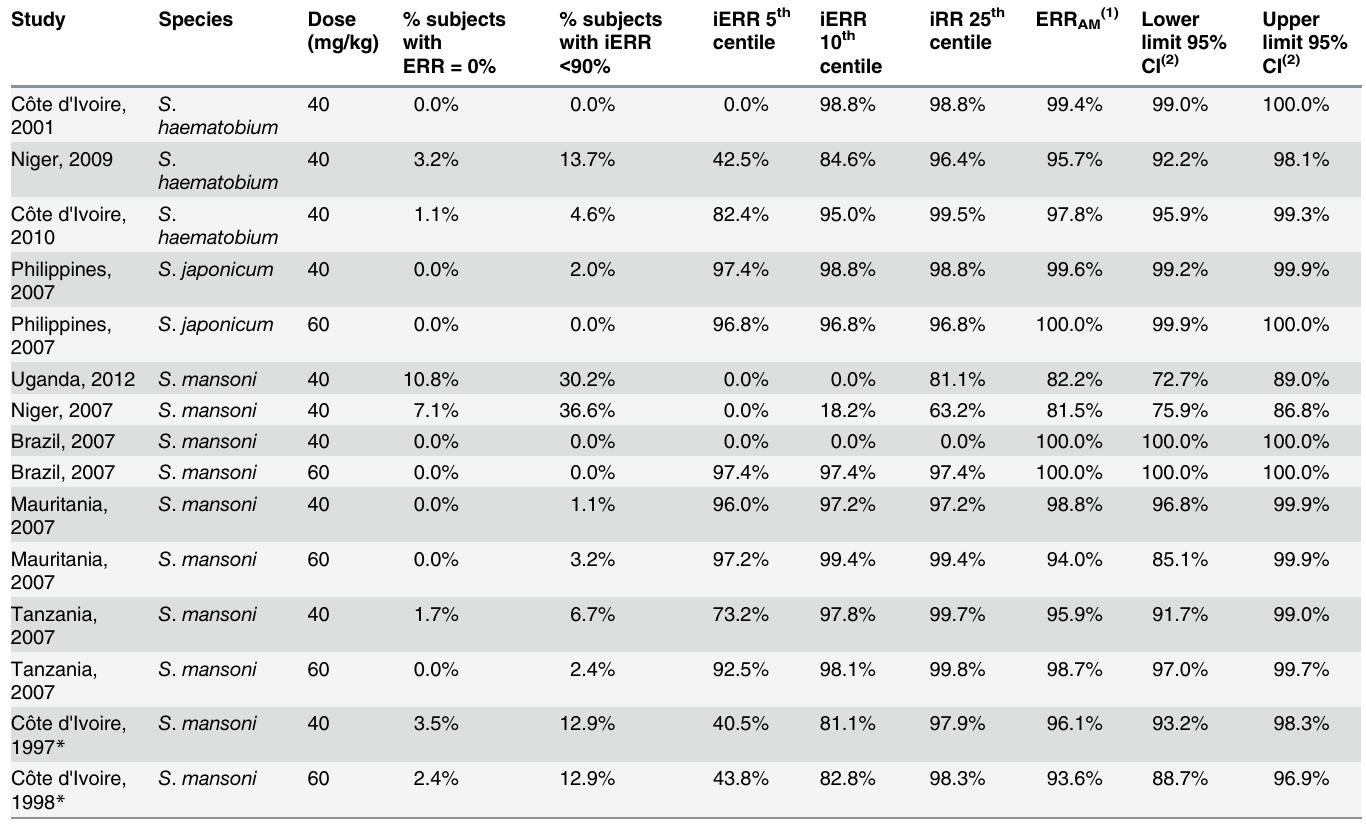
Table 3. Data outcomes at baseline in individual positives on single or quadruplicate Kato-Katz thick smears.